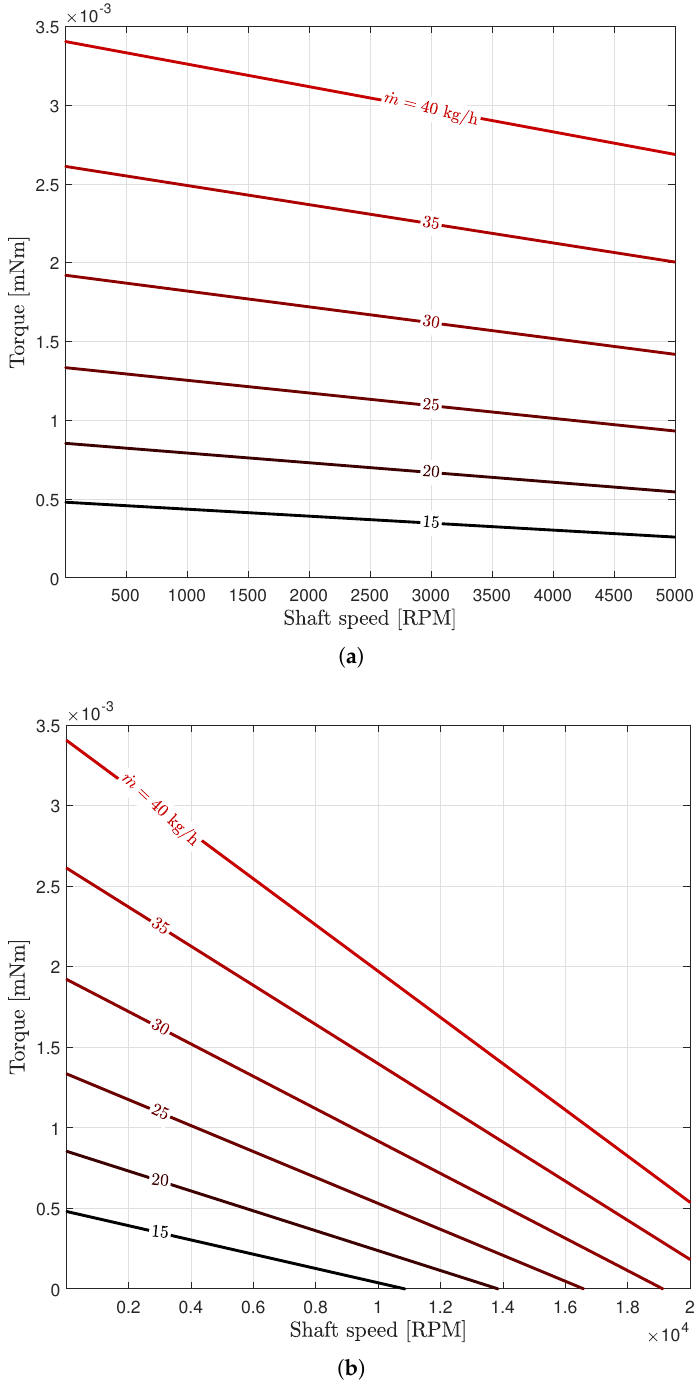
Figure 3. Generated torque vs. shaft speed for several mass flow rates. ( a ) Shows the torque generated by a shaft speed of up to 5000 RPM. ( b ) Shows the torque generated by a shaft speed of up to to 20,000